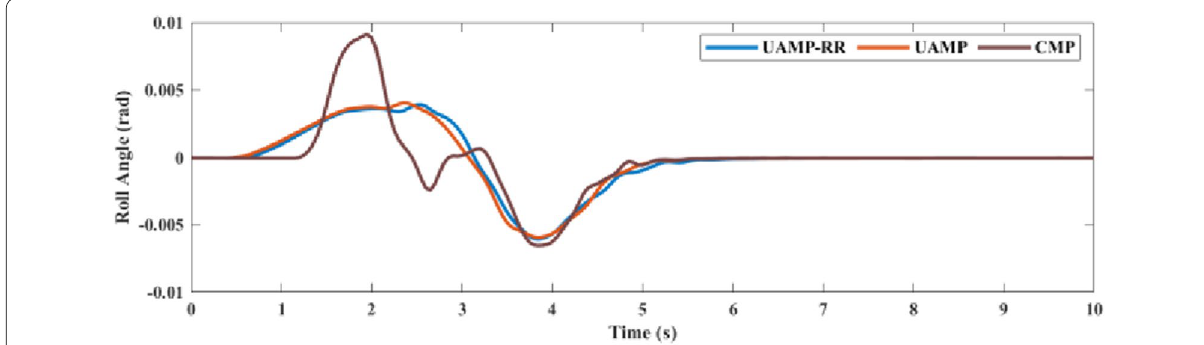
Figure 9 Roll angle of ego vehicle in case 1